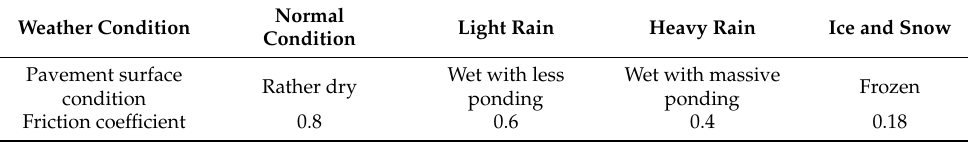
Table 4. Moisture conditions of pavement under different weather